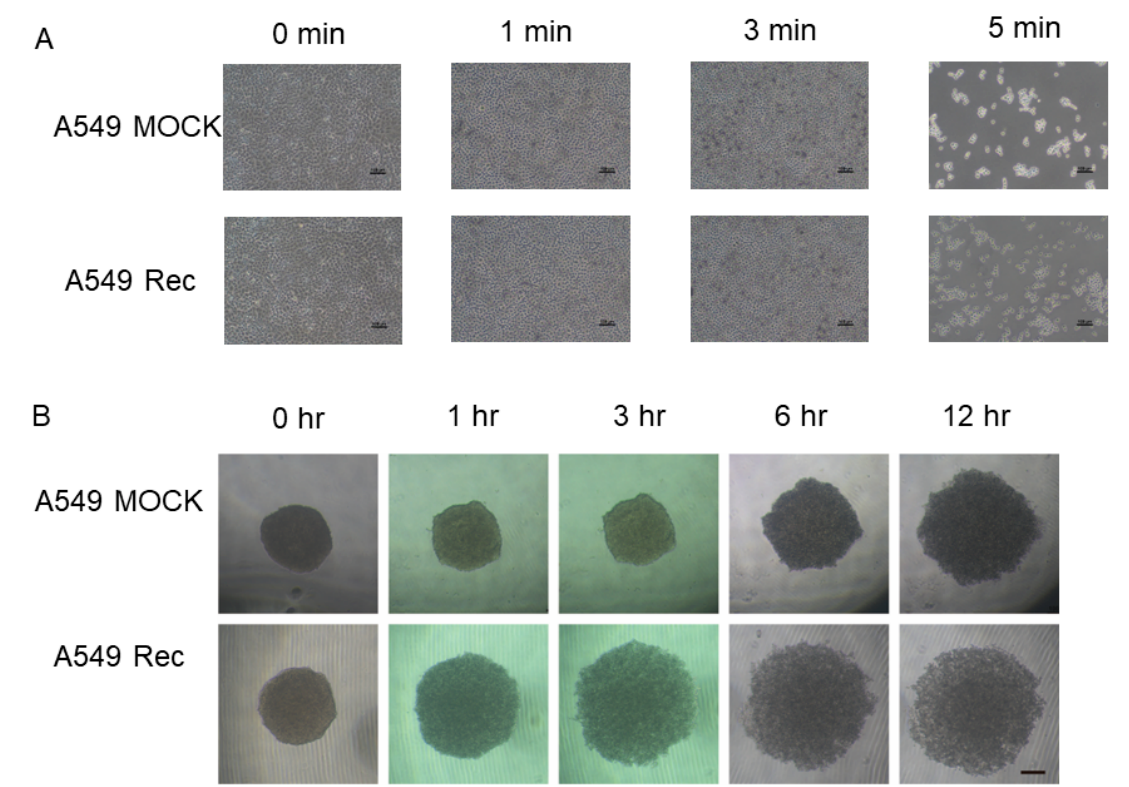
Figure 5. Trypsin digestion of 2D- or 3D-cultured A549 MCOK and A549 Rec. The 2D- or 3D-cultured A549 MOCK and A549 Rec were treated with 0.025% trypsin for 5 min or 12 h, respectively. Representative phase contrast microscopy images of 2D cells and 3D spheroids are shown in panels ( A , B ), respectively (scale bar; 100 µ m). Experiments were repeated in triplicate using fresh preparations (2D; n = 5, 3D; n = 10 spheroids each).